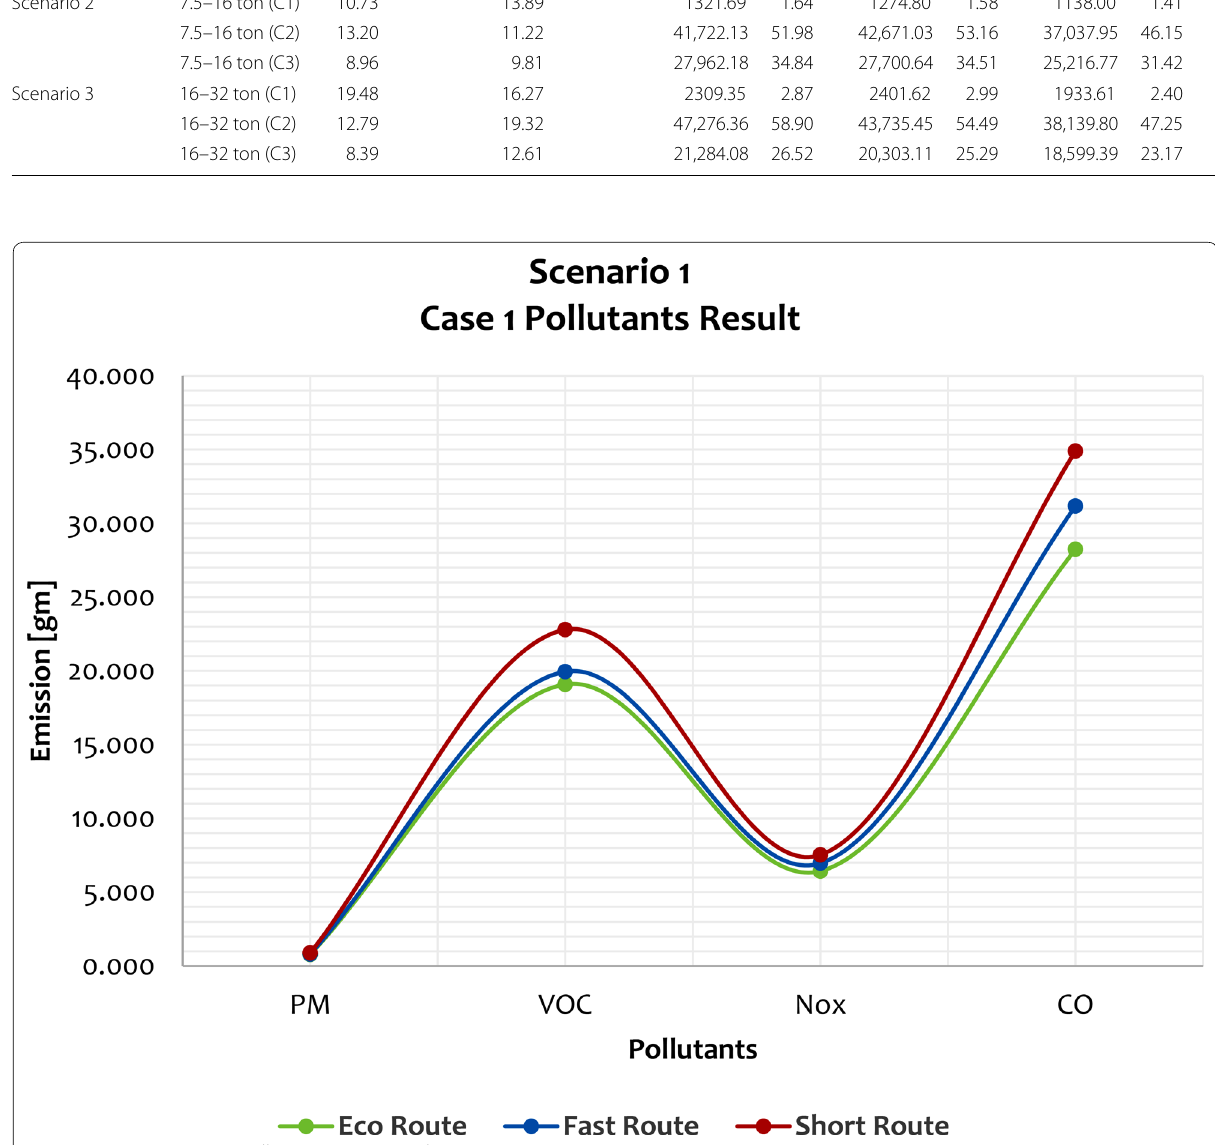
Fig. 14 Scenario 1 Case 1 pollutant emission